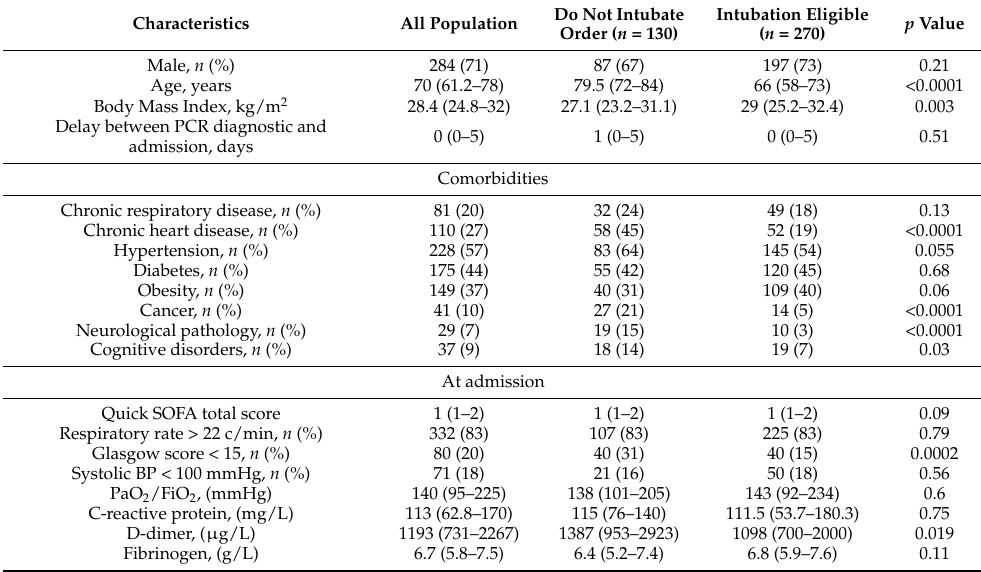
Table 1. Population characteristics.